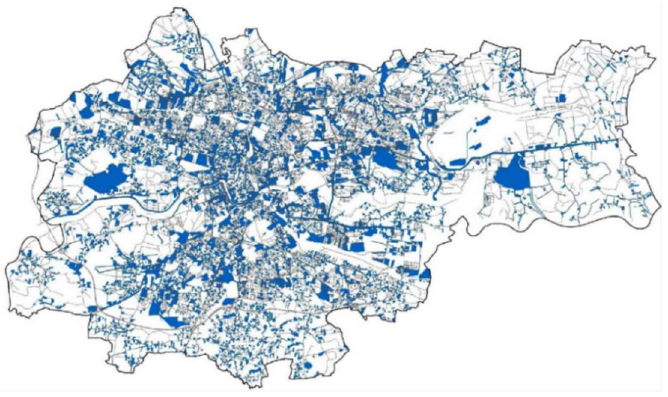
Figure 5. Map of binding location decision on building conditions as of 2003–2008. Resources: Bu-